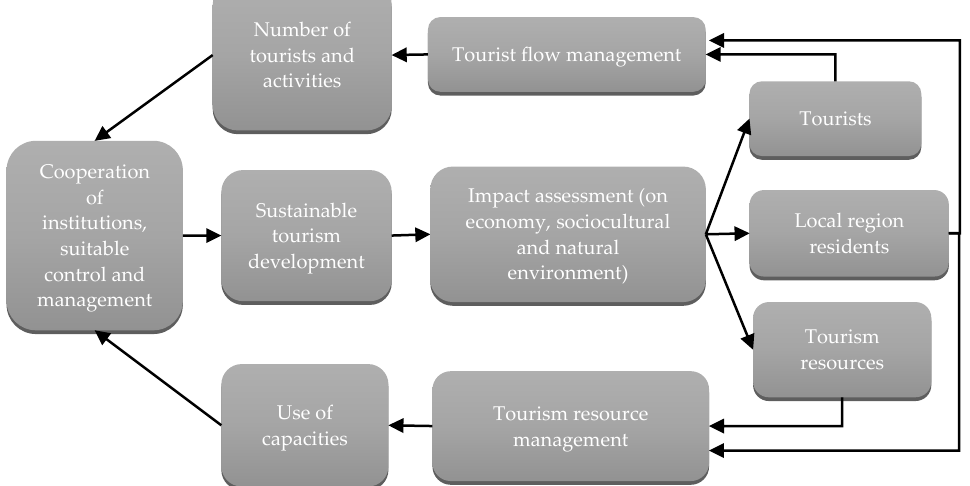
Figure 1. Sustainable tourism development model according to Sharpley . Source: Hopenienė and Kamičaitytė (2004). Darni turizmo plėtra: konkurencingos turizmo sistemos kūrimo prielaidos. Organizacijų vadyba: sisteminiai t yrimai, No. 29, p. 56.